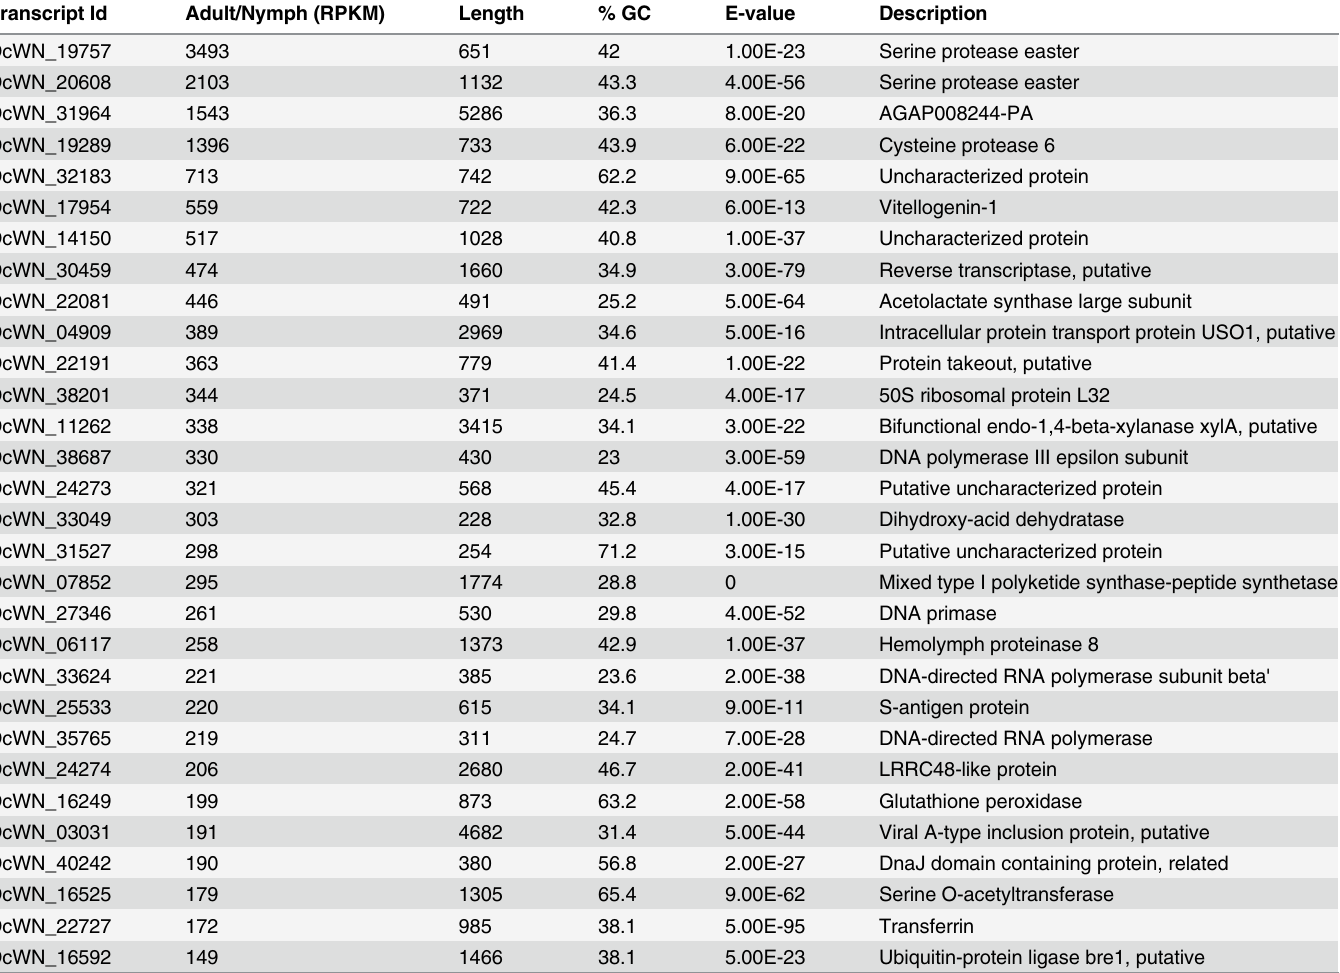
Table 2. Differentially expressed contigs from pairwise comparisons of the Ca . Liberibacter asiaticus-uninfected adult and nymphal instars of the Asian citrus